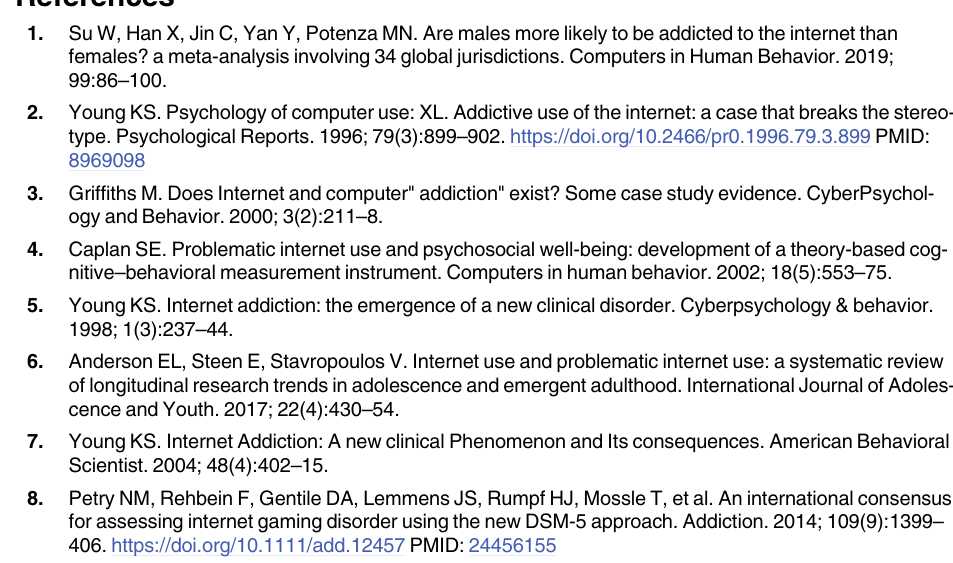
S2 Table. Distribution of missing and complete data across the study variables. S1 Fig. Histogram of internet addiction test